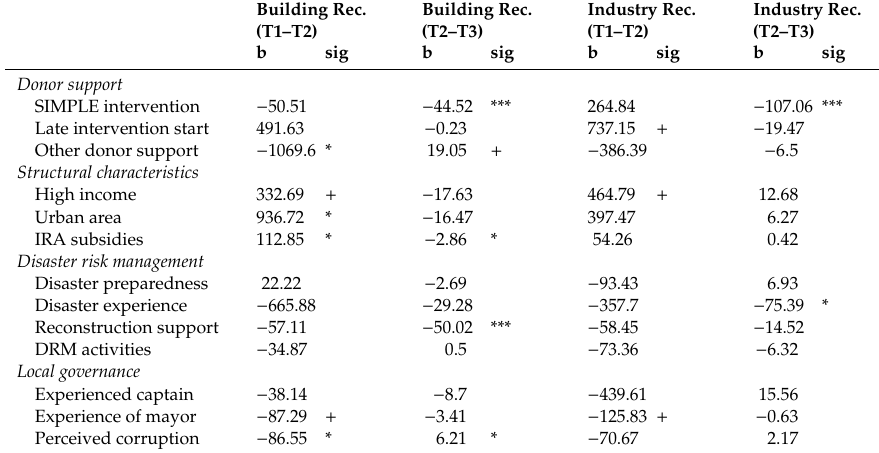
Table 7. Results from OLS regression models predicting building reconstruction and industry